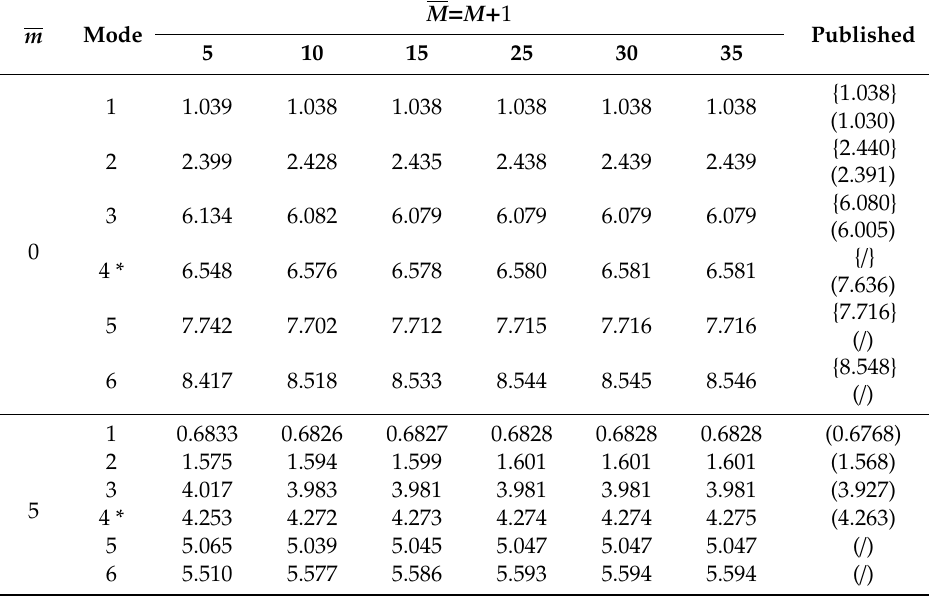
Table 4. Convergence of Ω for CFFF FGM square plates with h / b =